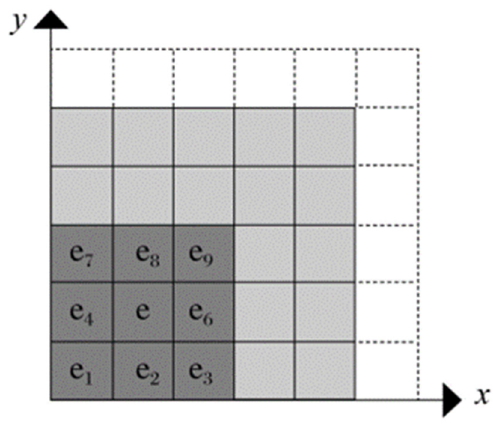
Figure 1. 3 × 3 grid calculation slope map.